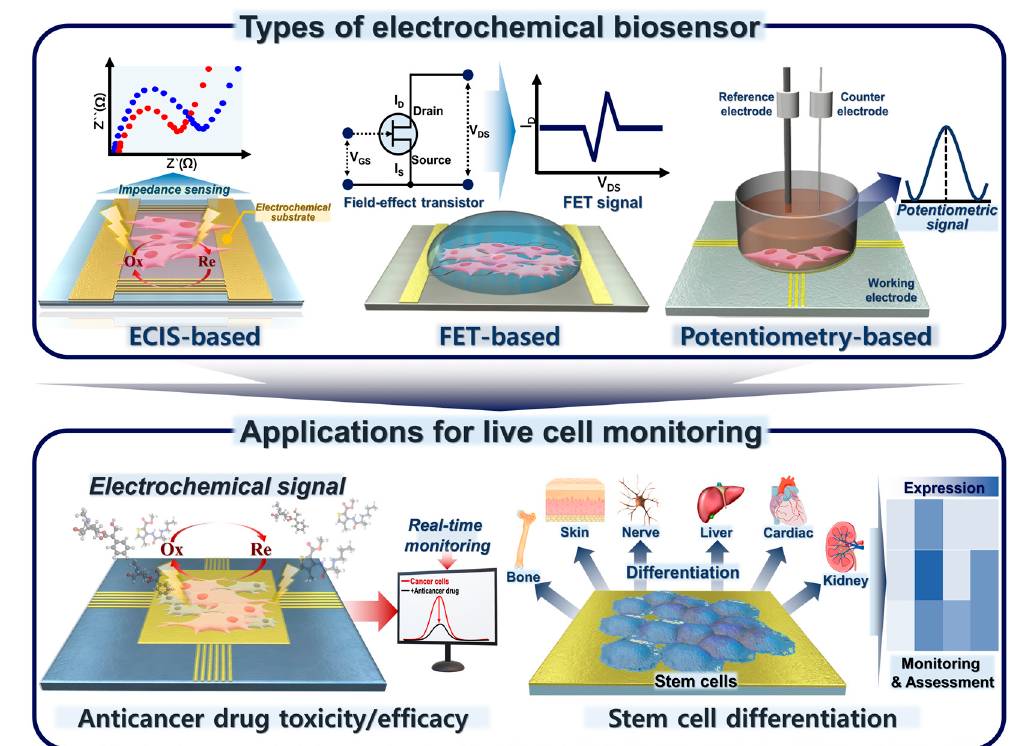
Figure 1. Schematic of various types of electrochemical biosensors for cancer/stem cell monitoring and their applications.